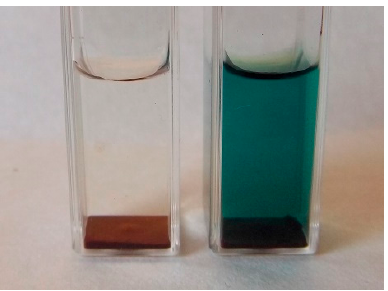
Figure 2. Formation of the green ABTS •+ by basidiospores of K. mutabilis in 1-cm cuvettes. Left, water control.